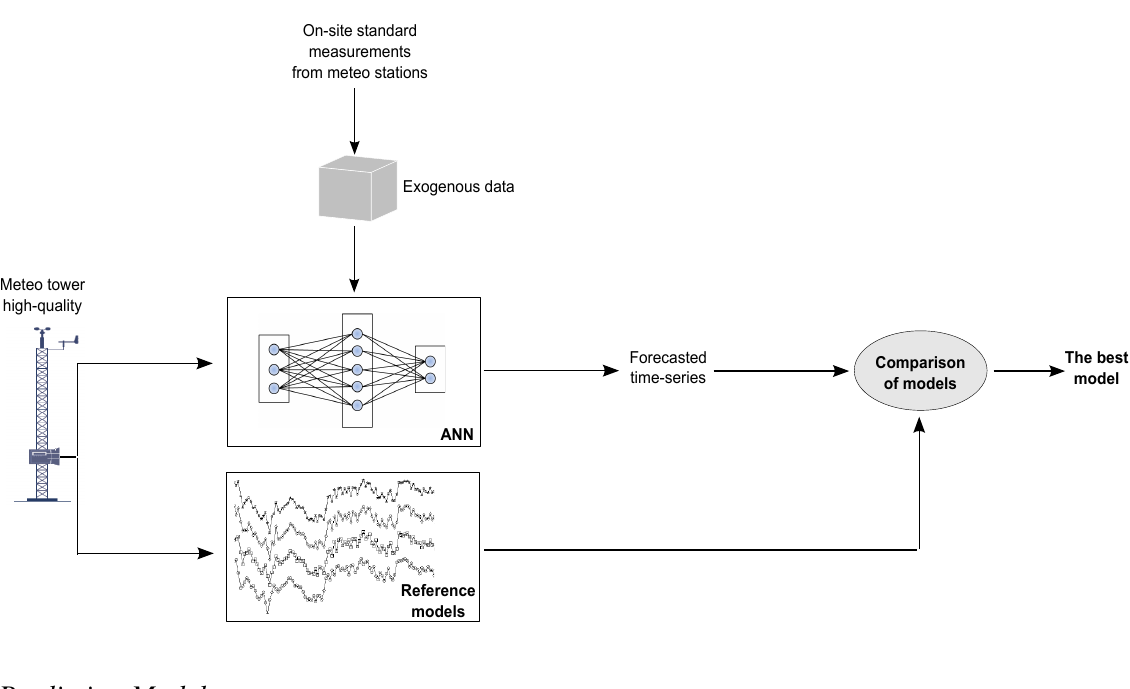
Figure 3. Graphical abstract of the paper and the